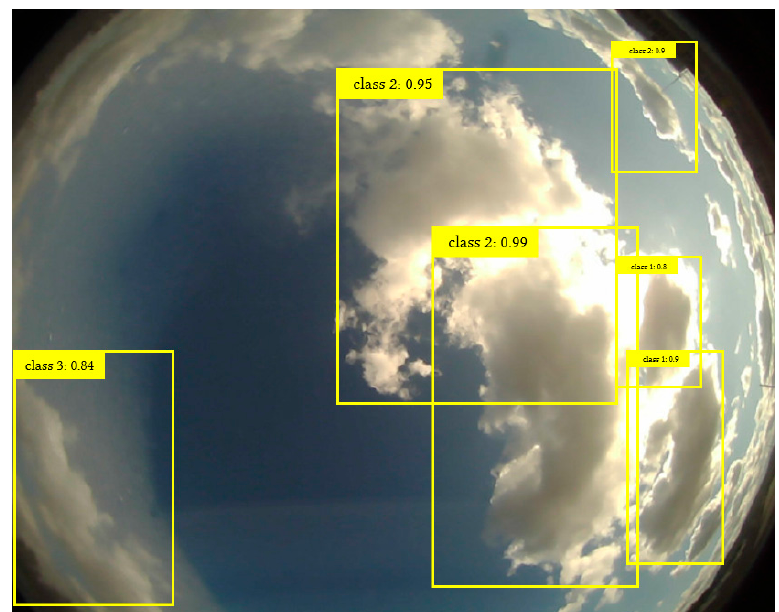
Figure 2. Object detection with retina net-like two-stage detector. Mask Head